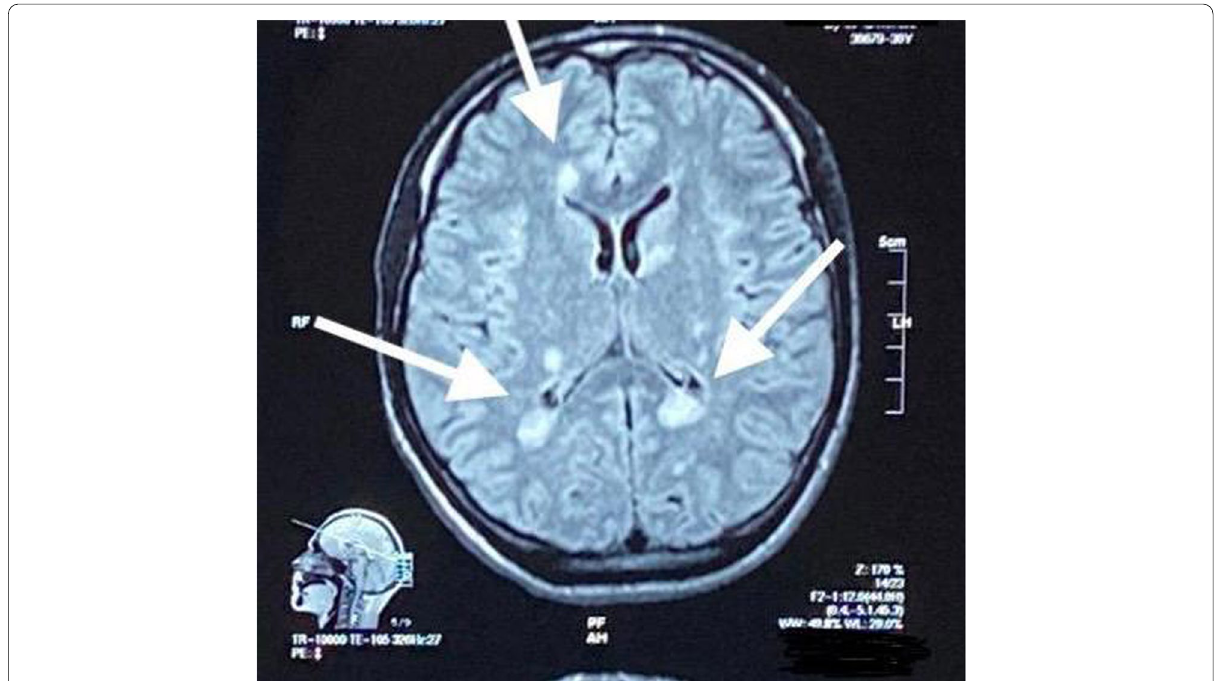
Fig. 1 MRI of the brain showing white matter internal capsule micro-infarcts as “string of pearls” appearance (white arrows)